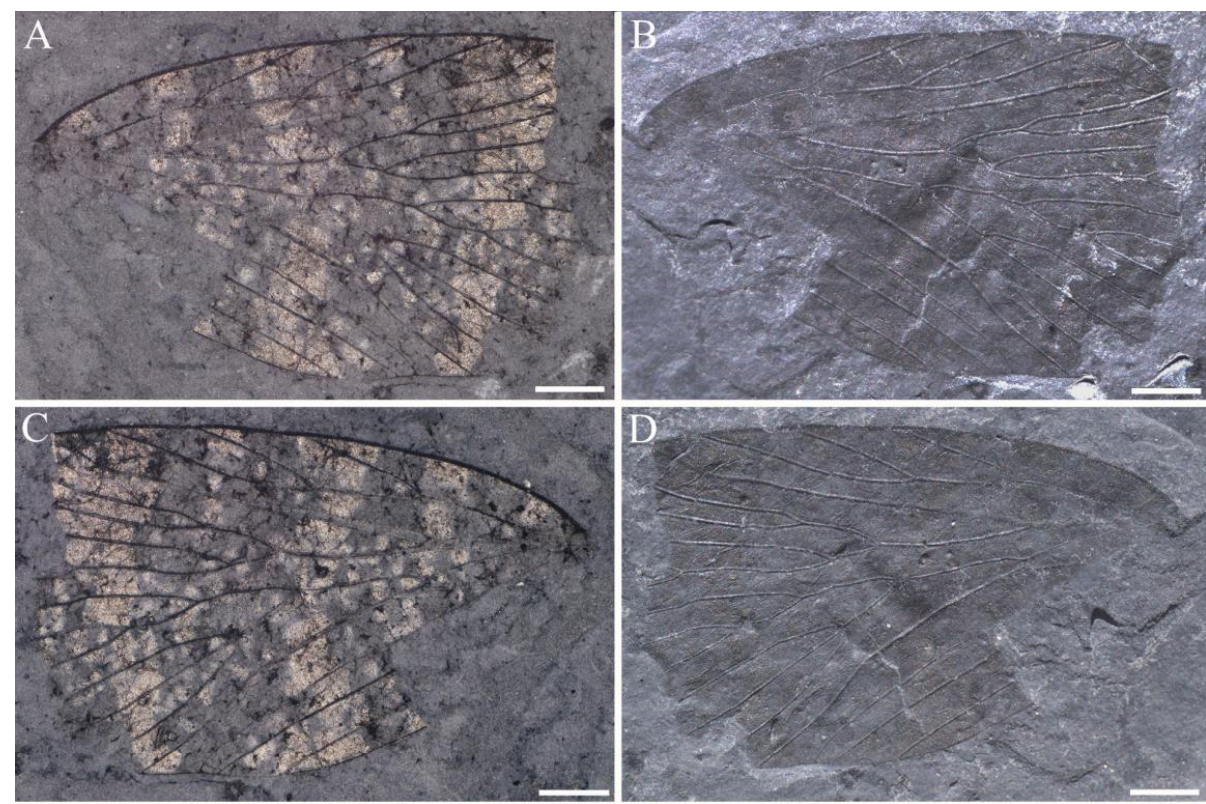
Figure 13. Sinoagetopanorpa magna sp. nov., NIGP200926 (holotype). ( A , B ) Photographs of part; ( C , D ) Photographs of counterpart; ( A , C ) were taken when specimens were immersed under 70% alcohol in vertical reflected light; ( B , D ) were taken in oblique reflected light. Scale bars represent 1 mm in ( A – D ).